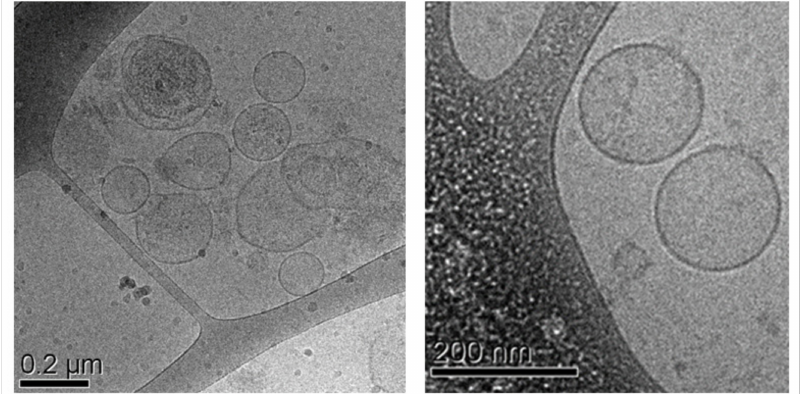
Figure 3. CryoTEM visualization of cBBMVs. CryoTEM, cryogenic transmission electron microscopy; cBBMV, colonic brush border membrane vesicles.